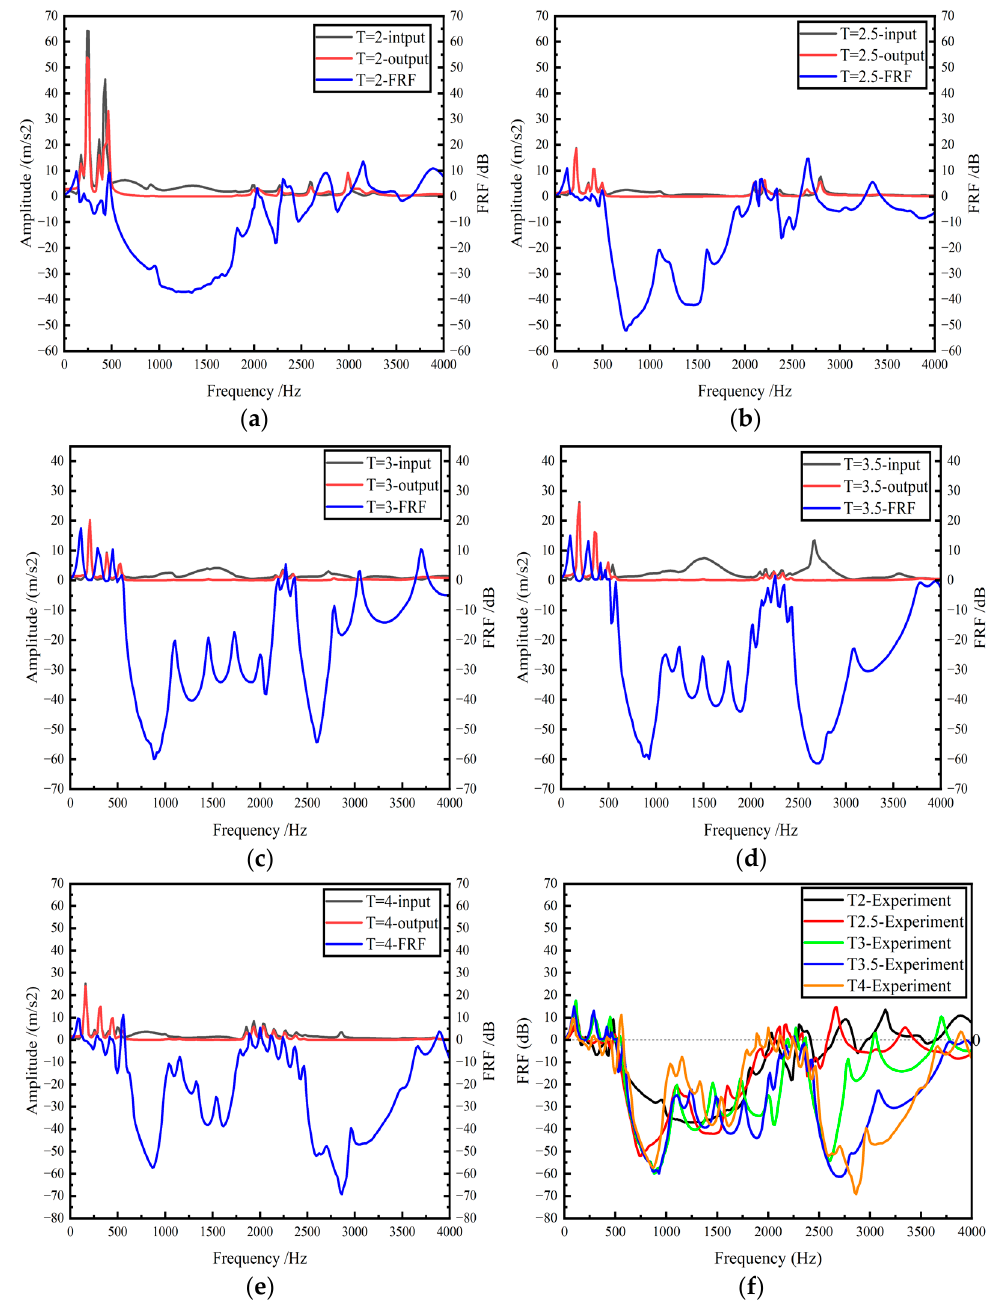
Figure 13. Frequency domain signals of GFRP wave springs and its FRF curve, ( a ) T = 2, ( b ) T = 2.5,